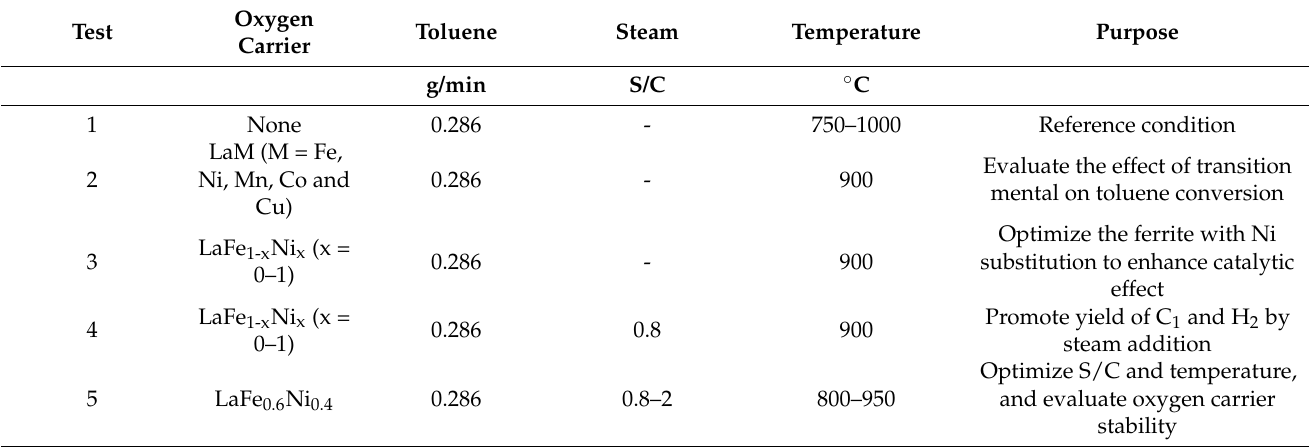
Table 1. Main experiment parameters for toluene